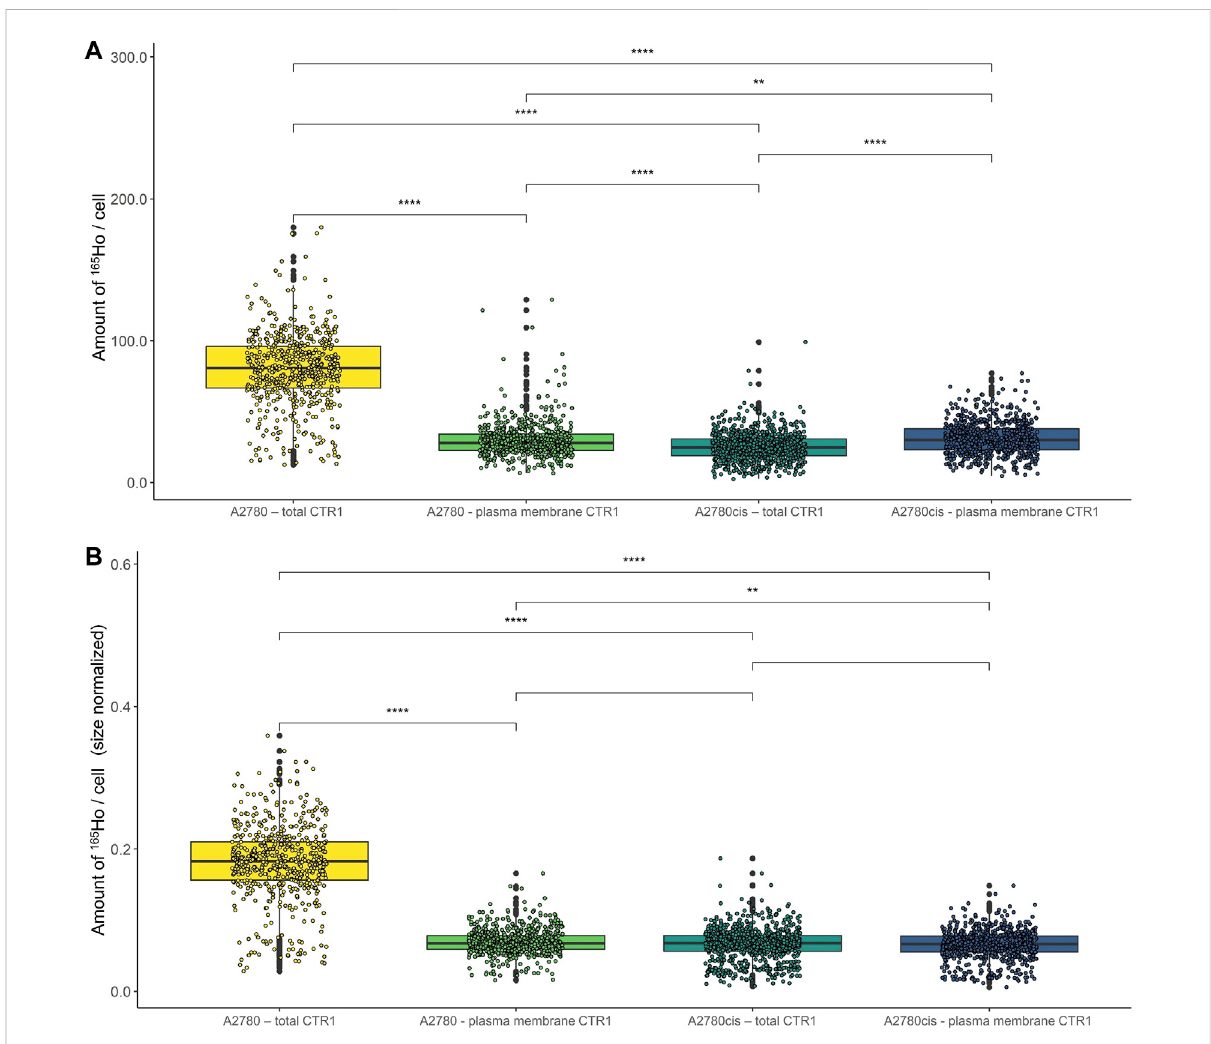
FIGURE 4 Boxplotsshowingtherelativeamountof 165 Hocell − 1 inA2780andA2780ciscells.Theintensityofthe 165 Hosignalcorrespondstotheamountof totalorplasmamembrane-boundCTR1.Theresultsareshown (A) withoutand (B) withpriorsizenormalization.Cytospinsamplesweremeasuredby